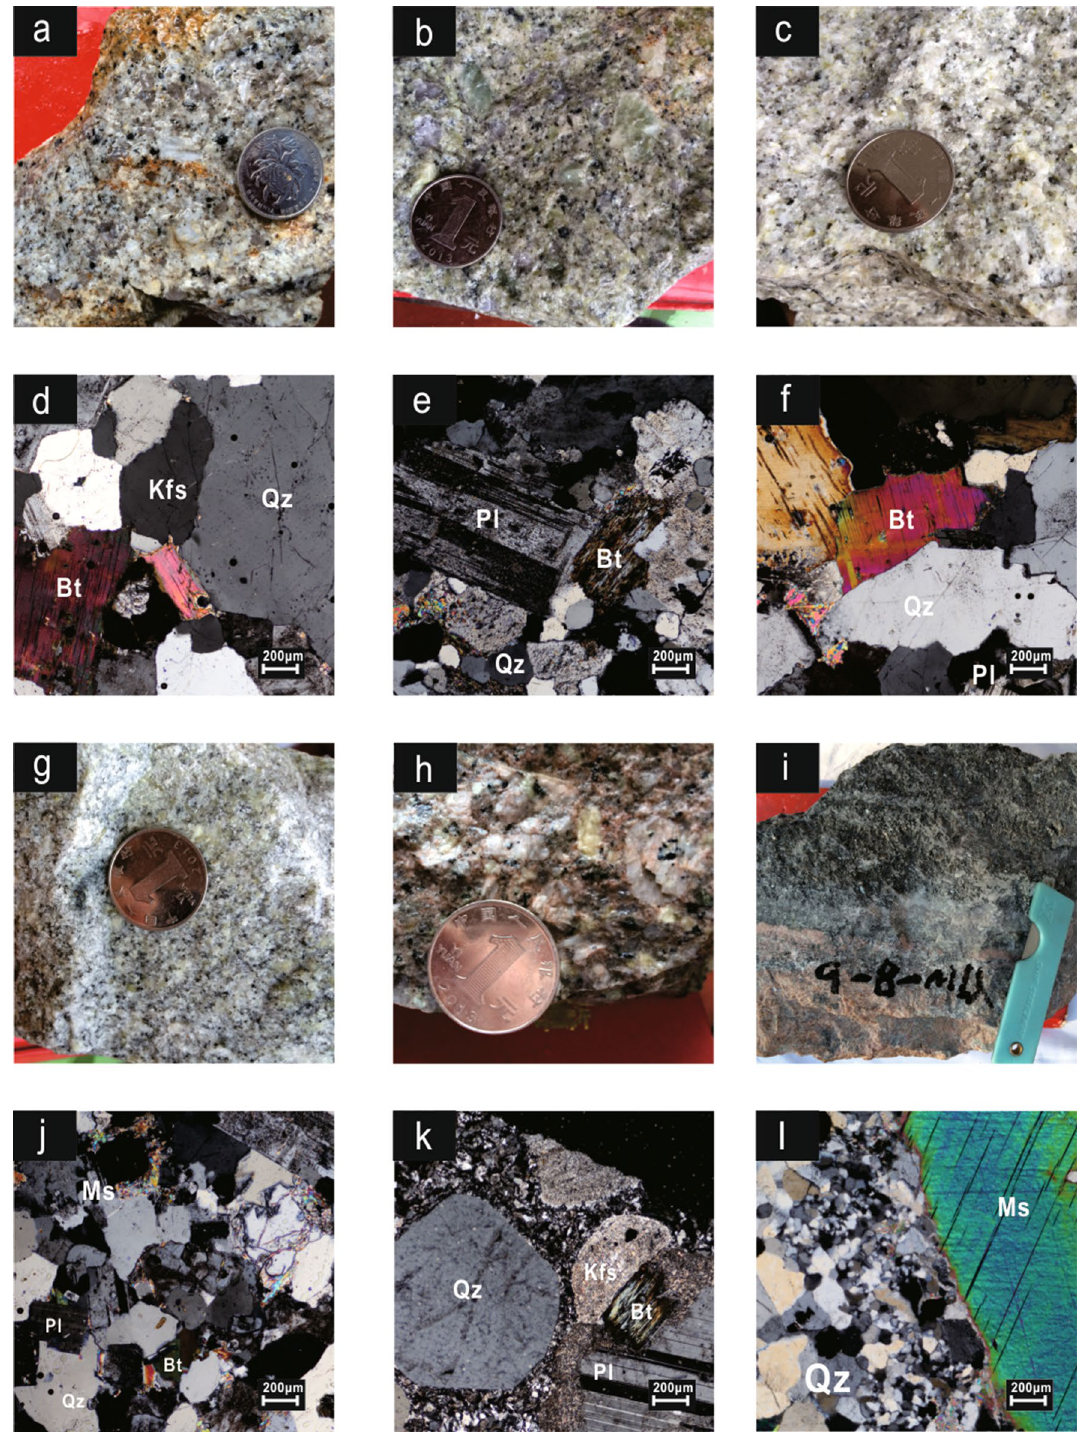
Figure 3. Photographs of the Qianlishan granites. ( a , d ) porphyritic biotite granite (Section 1: GL-13); ( b , e ) microfine-grained porphyritic biotite granite (Section 2: 315–36); ( c , f ) middle- to large-grained equigranular biotite granite (Section 3: 490–21); ( g , j ) fine-grained equigranular biotite granite (Section 4: 490–10); ( h , k ) granite porphyry dikes (Section 5: 490–2); ( i , l ): muscovite vein with mineralization. Abbreviations: Qz , Quartz; Pl, Plagiarize; Bt, Biotite; Ms, Muscovite (Whitney DL and Evans BW et al. 2010) 53